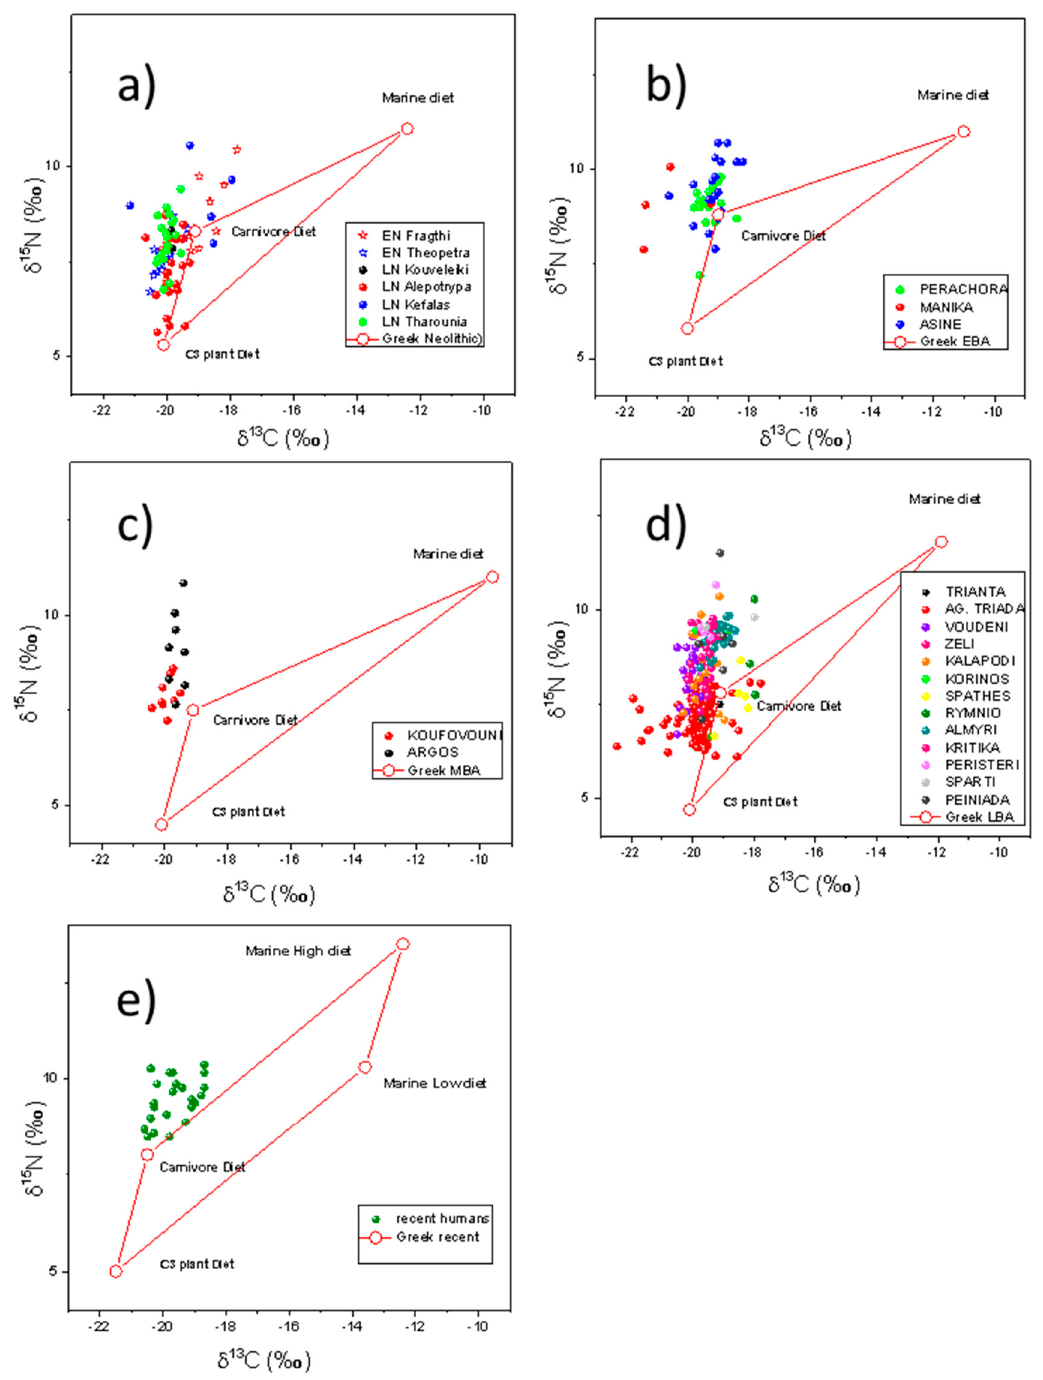
Figure 2. ( a ), ( b ), ( c ) and ( d ) δ 15 N and δ 13 C values of human bone collagen as published in the literature covering the Neolithic (EN: Early Neolithic, LN: Late Neolithic), Early Bronze, Middle Bronze and Late Bronze age, respectively. ( e ) δ 15 N and δ 13 C values of human hair samples of contemporary Greek population. The red rectangles indicate the theoretical isotopic values of human bone of a subject under 100% herbivore (lower left), 100% carnivore (upper left) and 100% marine diet (right low/high for low marine and high marine respectively). The values were deducted from fauna of the respectively periods and archaeological sites, as published in the literature and for ( e ) from measurements of contemporary Greek food sources (Tables 3 & 4).